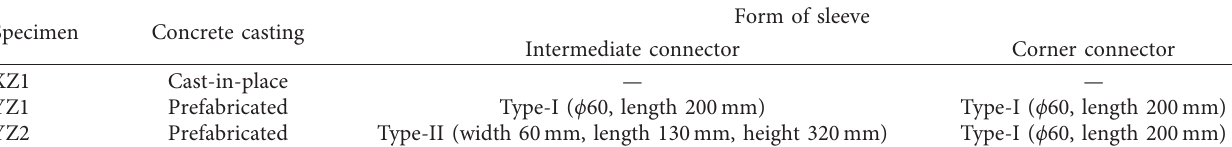
Table 2: Casting method of the specimen and connection form of the longitudinal steel